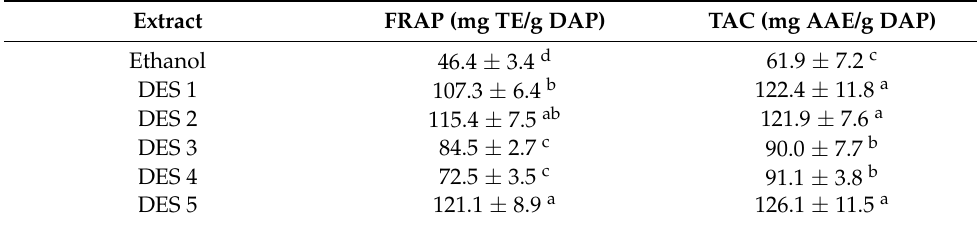
Table 3. Antioxidant capacity of the phenolic extracts from avocado peel obtained with five DES and